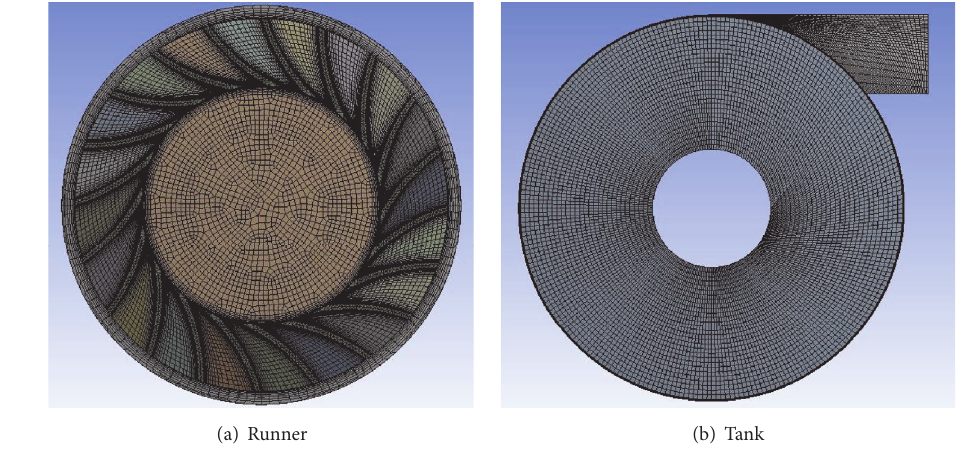
Figure 6: Computational grids.